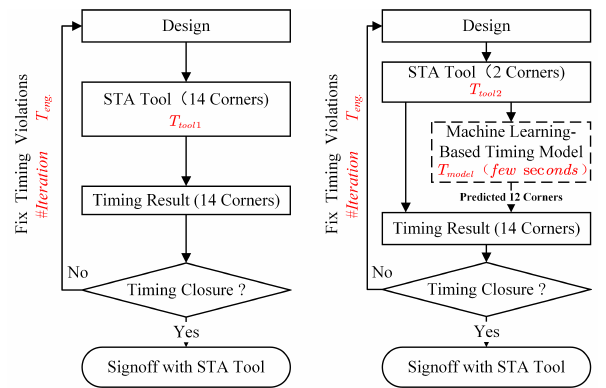
Figure 10. The commercial timing closure process ( left ) and machine-learning-based timing closure process ( right